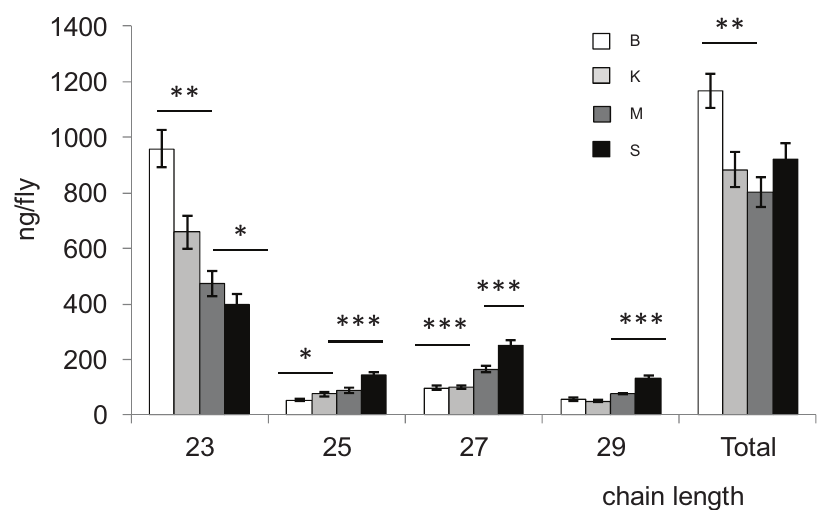
Figure 2. Amount of hydrocarbons of different lengths extracted from male ( top ) and female ( bottom ) D. yakuba flies from Bioko (B), Kounden (K), Mayotte (M) and Sao-Tome (S) populations. Total: C23 to C29; Each bar represents mean ± SEM ( n = 10). *, ** and *** above bars indicate significant differences (one-way ANOVA, p = 0.05, 0.01 and 0.001, respectively) between means.